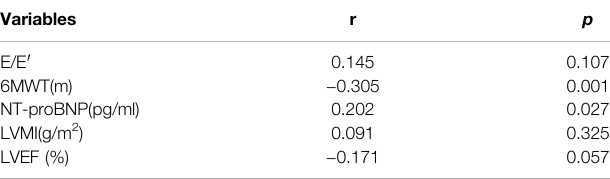
TABLE 3 | The correlation between MEE and multiple variables.